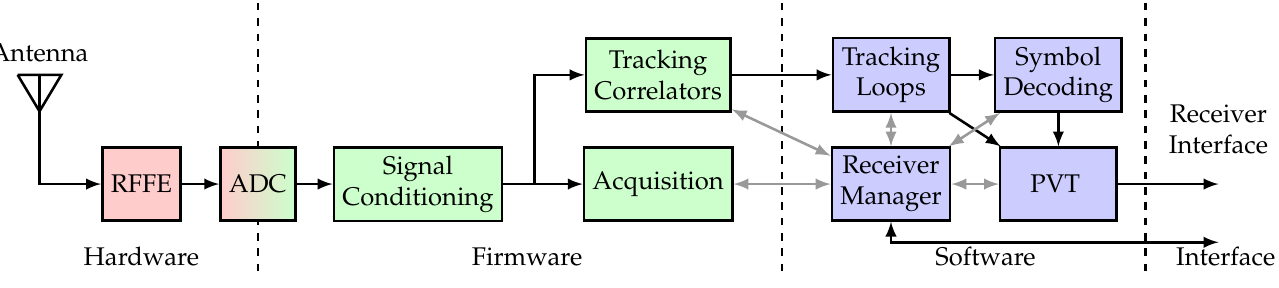
Figure 14. GOOSE architecture